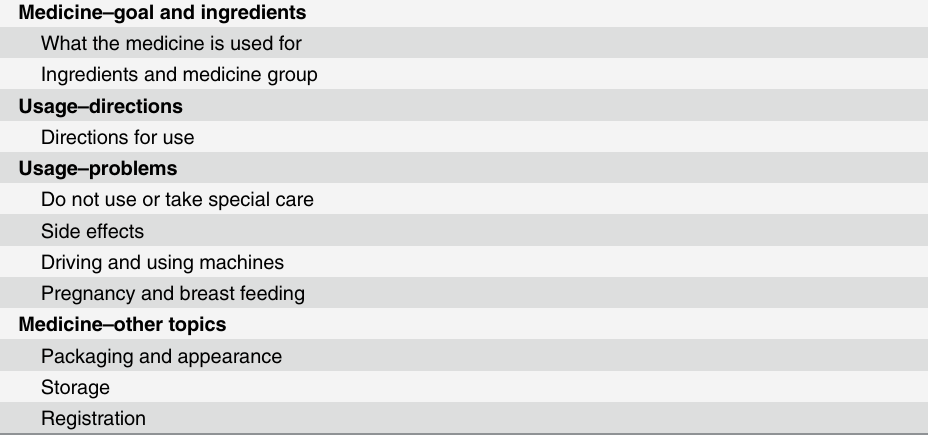
Table 2. Alternative template structure proposed by Pander Maat & Lentz